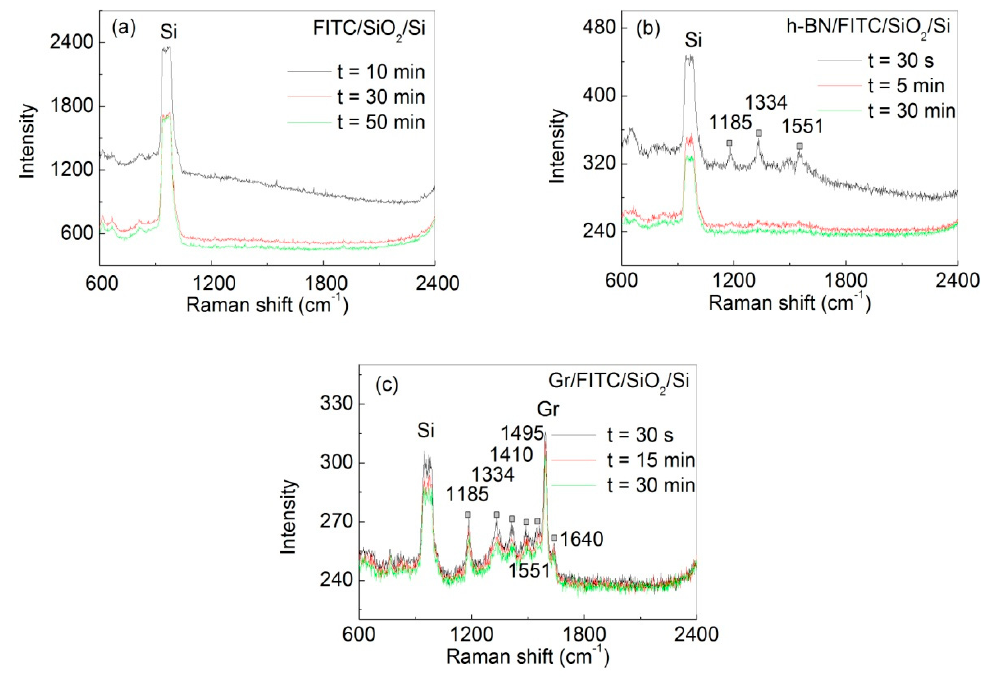
Figure 5. Raman spectra of FITC dye molecules in different structures: ( a ) FITC/SiO 2 /Si (Raman integration time was 10 min with 10 min delay between measurements); ( b ) h-BN/FITC/SiO 2 /Si (Raman integration time was 30 s with 30 s delay between measurements); and ( c ) Gr/ FITC/SiO 2 /Si (Raman integration time was 30 s with 30 s delay between measurements). Raman was measured at the same location in each sample. Peaks marked with “ ■ ” are from the FITC dye. Note that the SiO 2 substrates used here were not modified with APTES, which results in lower surface coverage of FITC dye.